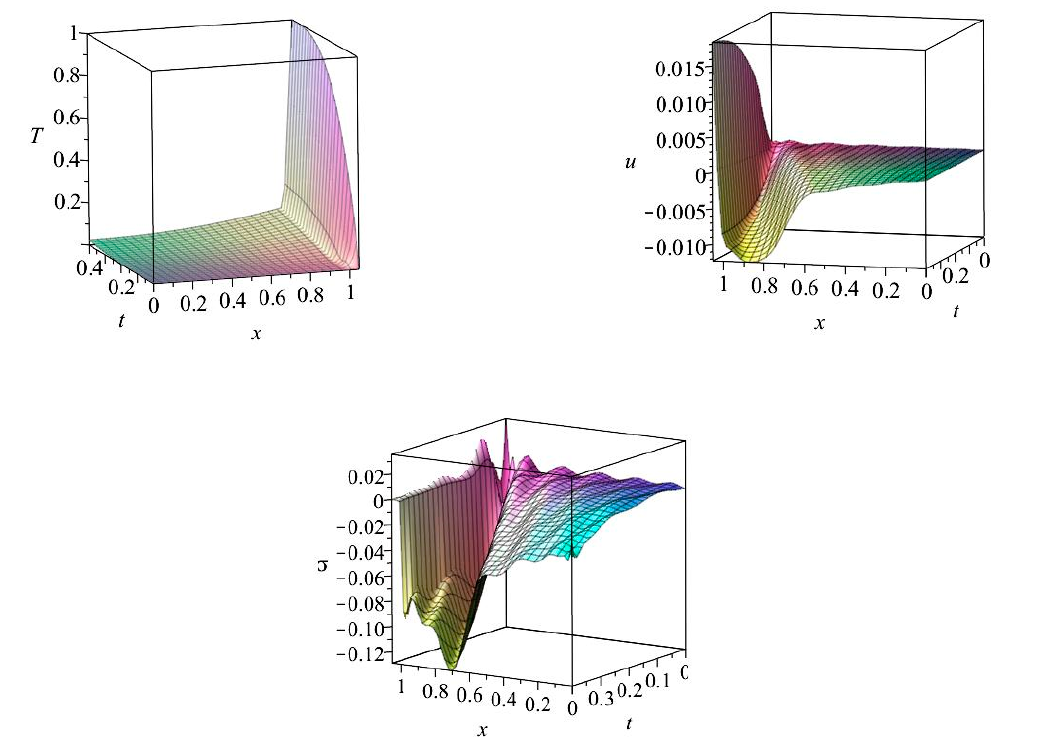
Figure 7. The thermal conductivity coefficient for layer 2 as in Table 1, the thickness of layer 2 is two times smaller. Figure 6 shows a significant influence of the thickness of layer 2 and its thermal con- ductivity coefficient on the values of temperature and displacements in layer 2 at signifi- cantly reduced stresses in this layer. Figure 7 shows that reducing the thickness of layer 2 slightly increases the temperature in layer 1, slightly reduces the displacements on the outer edge of layer 1, and slightly disturbs the stresses. 7. Conclusions The application of the Trefftz functions to the approximate solution of the thermoe- lastic problem in a single- and double-layered medium showed the effectiveness of the Trefftz method in connection with the method introduced in the article for determining particular solutions of coupled thermoelasticity equations. However, the solution proce- dure requires a powerful computer that will approximate solutions with high-order pol- ynomials. The temperature and displacement fields in one and two layers could be ob- tained in a satisfactory form for a small number of T-functions (even for the solutions to be approximated by a 10-degree polynomial). The calculation of stresses requires a much higher degree of the approximating polynomial, due to the differentiation in Formula (13), which introduces significant undulations in the stress diagram. The applied method ob- tains an analytical solution with numerically determined coefficients at the Trefftz func- tions. As composite materials are used on a larger scale, a rationale for research is the effect of sudden changes in their thermophysical properties [29,30]. The presented problem of thermo-structural analysis is part of this research area.